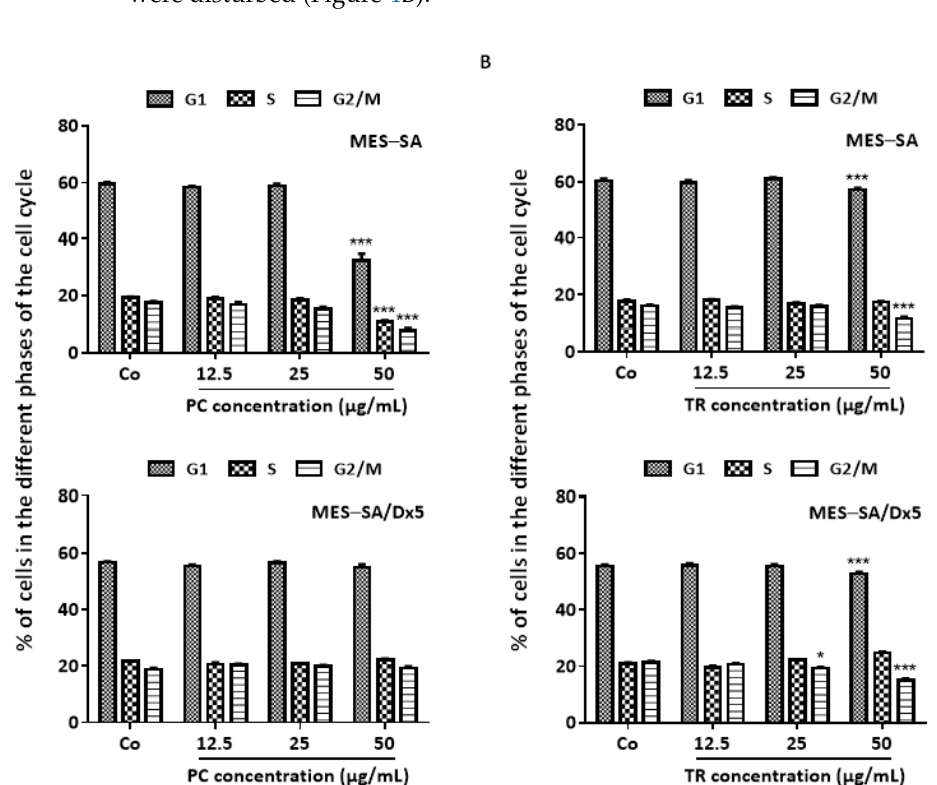
Figure 4. Quantifications of cell cycle distribution in MES-SA and MES-SA/Dx5 after a 72 h Pituranthos chloranthus (PC) and Teucrium ramosissimum Desf. (TR) extract treatment. Quantitative analysis of cell cycle distribution in PC-treated MES-SA and MES-SA/Dx5 ( A ) and TR-treated MES-SA and MES-SA/Dx5 ( B ). Data are expressed as mean ± Standard Error of the Mean (SEM) of three independent experiments; p -values were determined by a two-way ANOVA followed by Dunnett’s multiple comparison test. * p < 0.05 and *** p < 0.001 compared to control (Co) conditions. G1, Gap 1 phase; S, synthesis phase; G2/M, Gap 2/Mitosis phase.